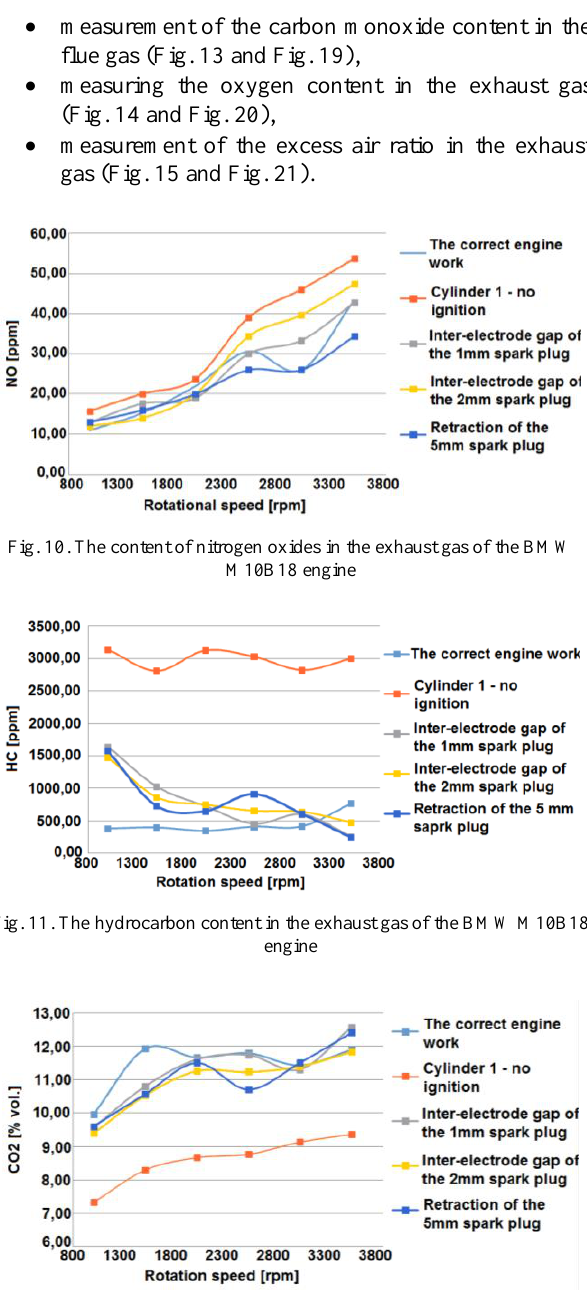
Fig. 12. The carbon dioxide content in the BMW M10B18 engine exhaust gas